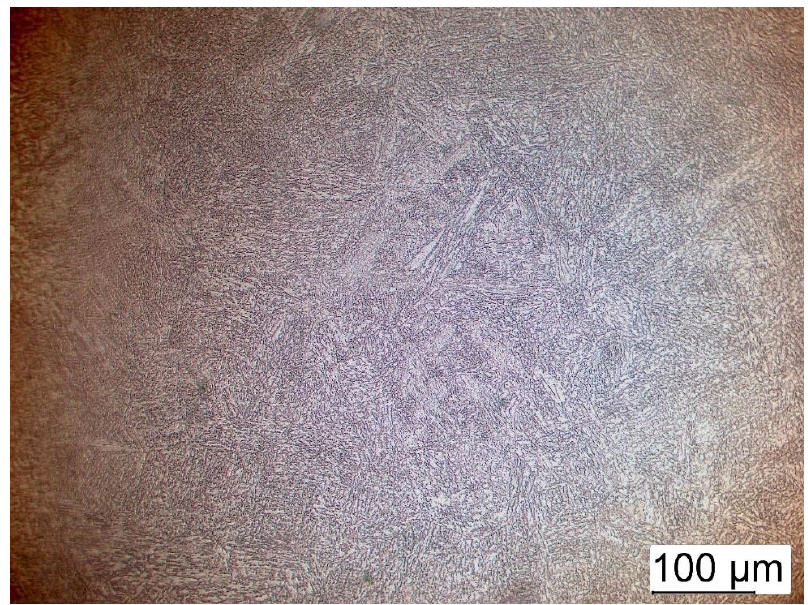
Figure 8. Micrography of the pinion shaft head near the flash area after forging.